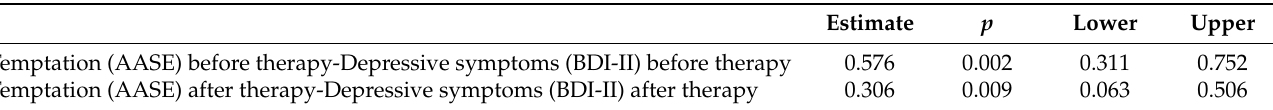
depressive symptoms in the investigated group before and after therapy.